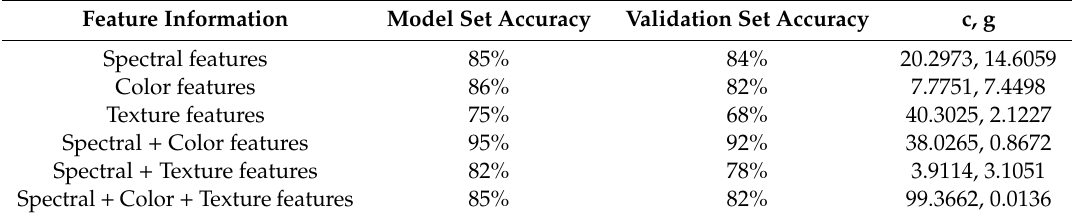
Table 2. PSO_SVM model prediction results for di ff erent feature information.